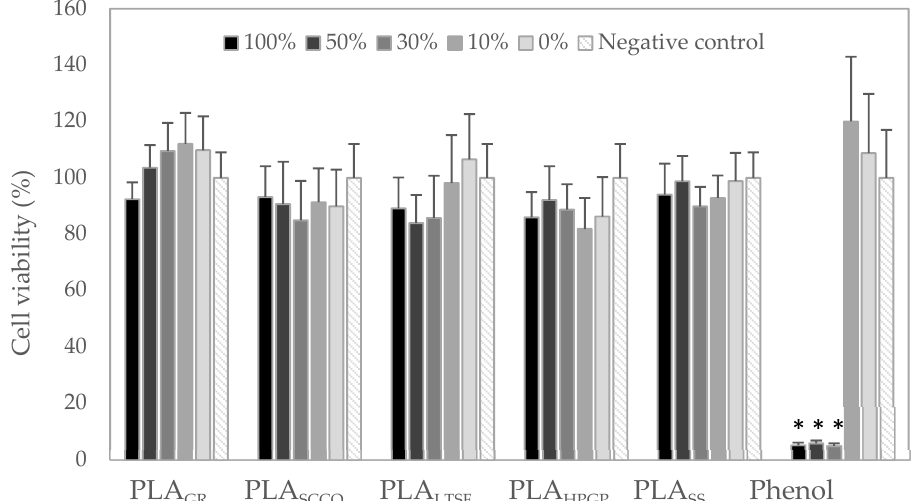
Figure 8. Cell viability detected in mouse fibroblast cells (NCTC clone 929) in the presence of different extracts of PLA GR , PLA SCCO , PLA LTSF , PLA HPGP and PLA SS discs, compared to the positive control (phenol) and negative control (DMEM). Results are expressed as percentage compared to the negative control ± standard error. Statistical significance was determined to * ( p ≤ 0.05).